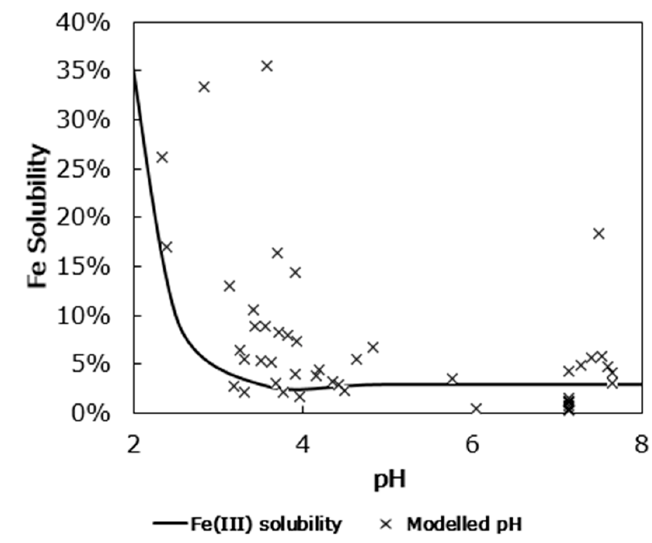
Figure 4. The pH, modelled via ISORROPIA-II, for samples from the BIOS, GEOTRACES, and Finokalia Research Station sample sets shows that only when the pH is below approximately 4, or under acidic conditions, does the pH affect the fractional solubility of iron. The behavior of fractional solubility of aerosol iron as a function of pH is consistent with the speciation of Fe(III) (black line).